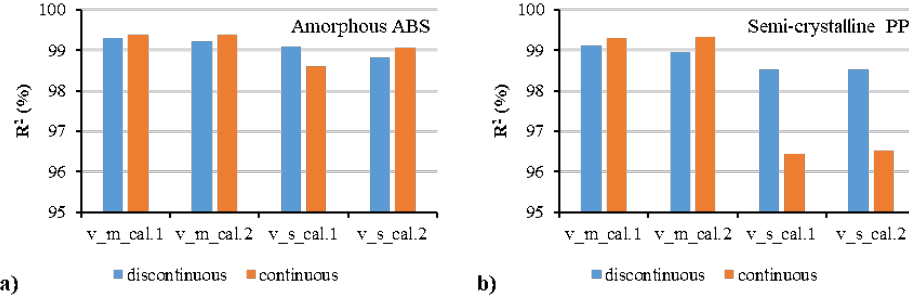
Figure 10. R-squared values of different models for the validation with the additional pvT data at two isobaric levels of 1400 and 1000 bar: amorphous ABS ( a ) and semi-crystalline PP ( b ).